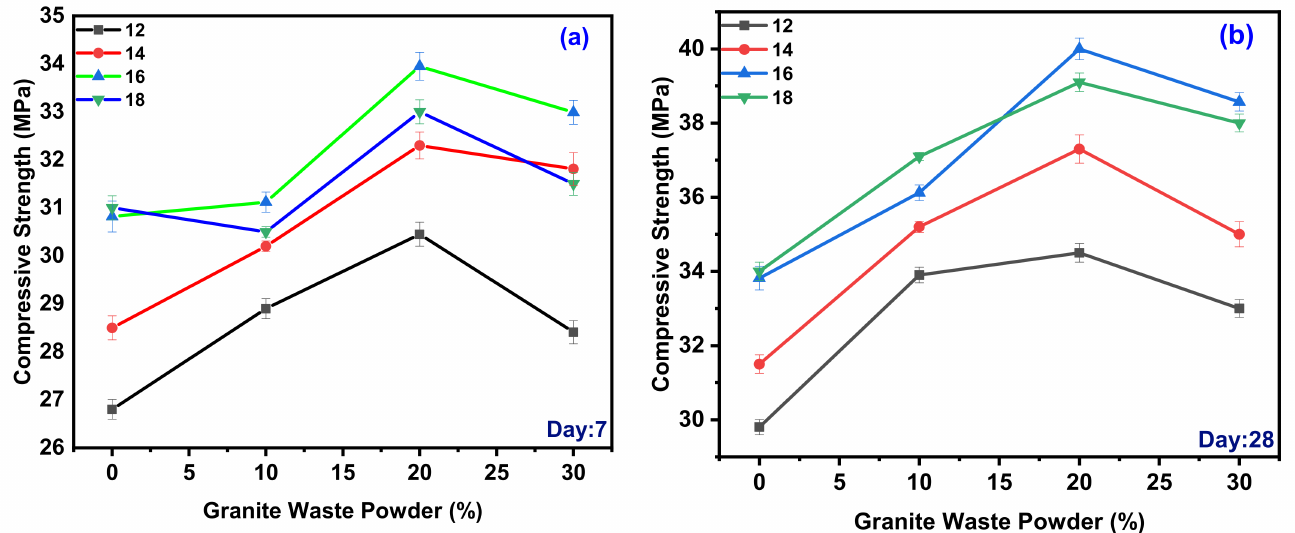
Figure 2. Variation of GWP on the different molarity for CS days 7 ( a ) and 28 ( b ). For 12 M of GPC, maximum CS observed for GWP with 20% with 34.5 MPa and minimum CS observed for GWP with 0% with 29.8 MPa. For 14 M of GPC, maximum CS was observed for GWP with 20% with 37.3 MPa and minimum CS observed for GWP with 0% with 31.5 MPa. For 16 M of GPC, maximum CS was observed for GWP with 20% with 40 MPa and minimum CS observed for GWP with 0% with 33.82 MPa. For 18 M of GPC, maximum slump was observed for GWP with 20% with 39.1 MPa and minimum CS was observed for GWP with 0% with 34 MPa. As the molar concentration increases, the CS increases. However, 16 M shows remarkably higher CS than other molars. It was also observed that the increase in the GWP content in the mix increases up to 20%, beyond 20% CS